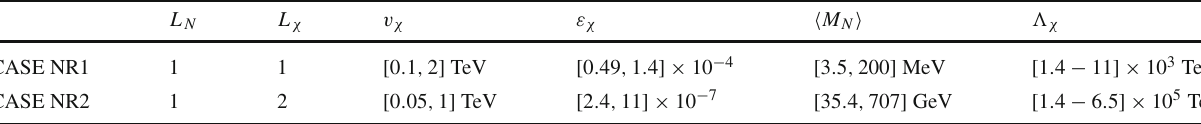
Table 2 Parameter ranges in the two phenomenologically interesting